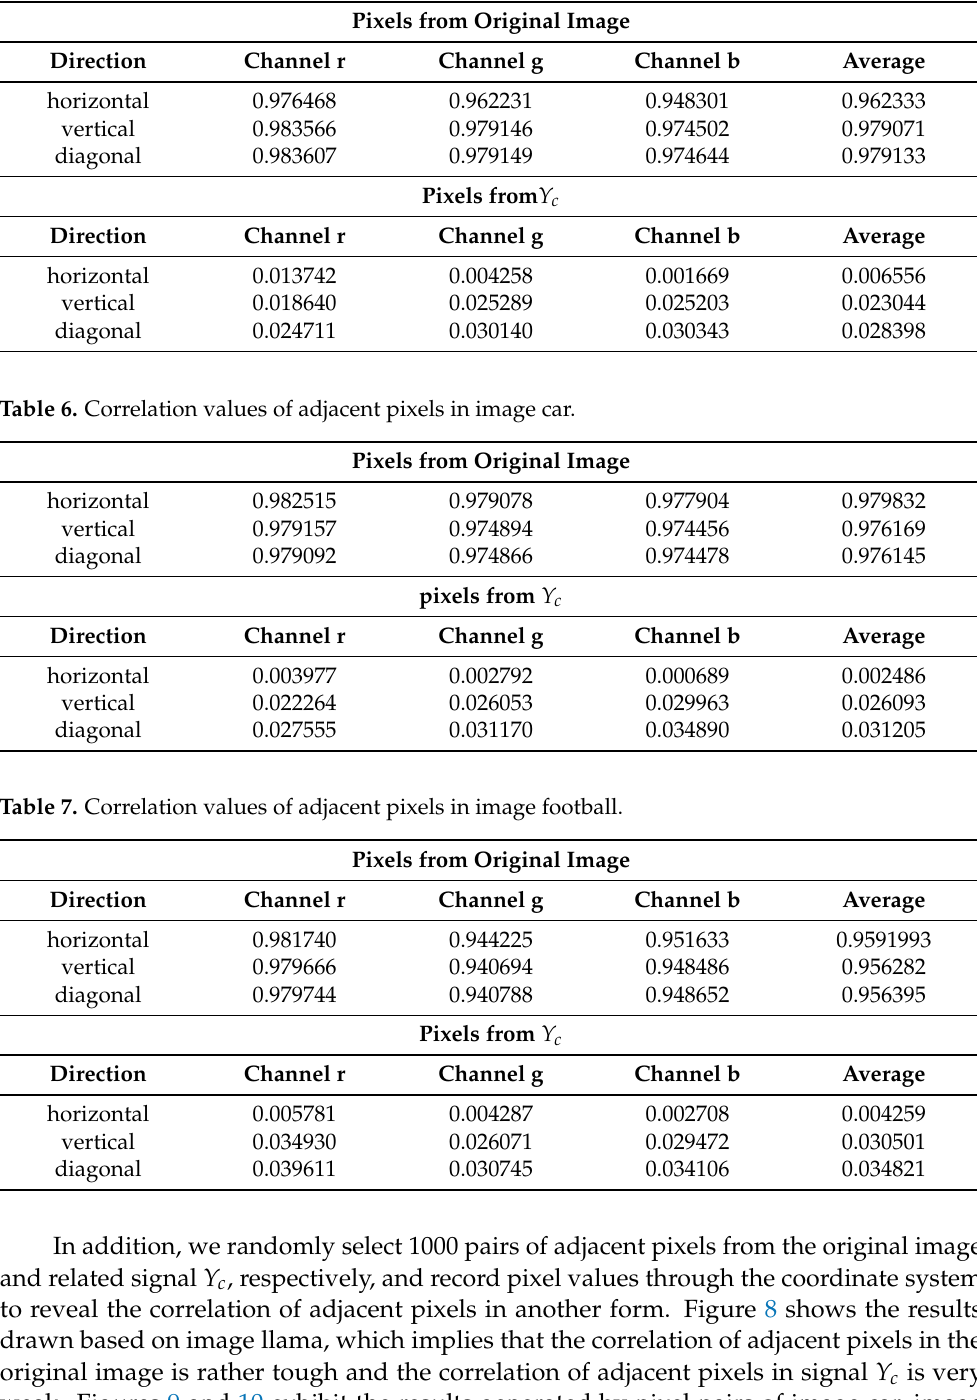
Table 5. Correlation values of adjacent pixels in image llama.